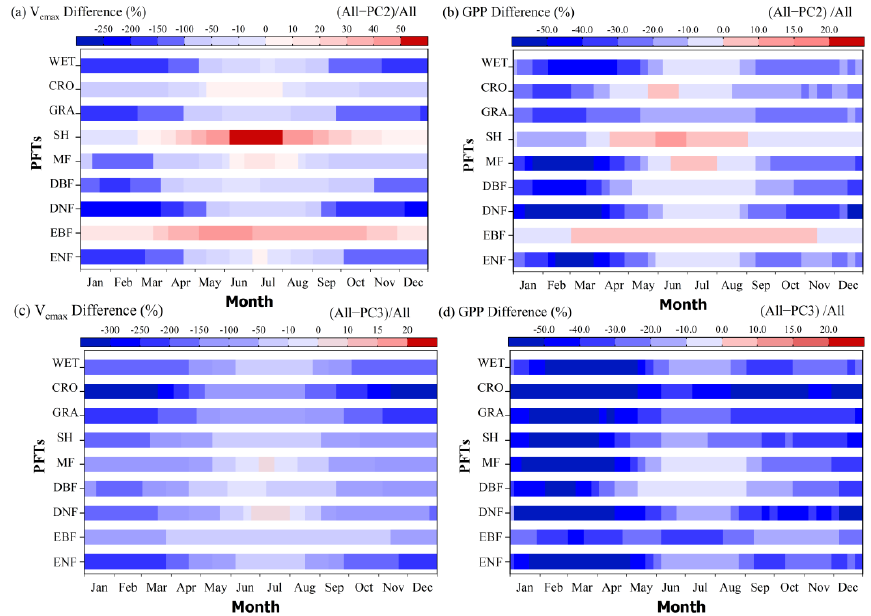
Figure 8. Relative differences in V cmax and corresponding relative GPP differences caused by changes in V cmax with the seasons. ( a ) The relative differences in V cmax between LCC-derived V cmax and TRY- based V cmax ; ( b ) the corresponding relative difference in GPP caused by changes in V cmax . ( c ) The differences between LCC-derived V cmax and the calibrated V cmax ; ( d ) the corresponding difference in GPP caused by changes in V cmax .